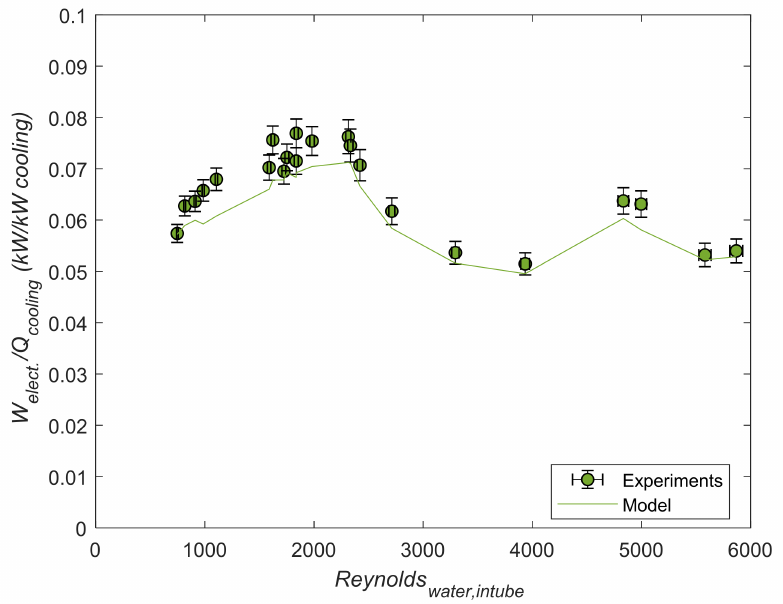
Figure 11. Experimental energy to cooling capacity ratio for different water Reynolds numbers at a constant air and spray flow rate, and the constant approach temperature of 4 ◦